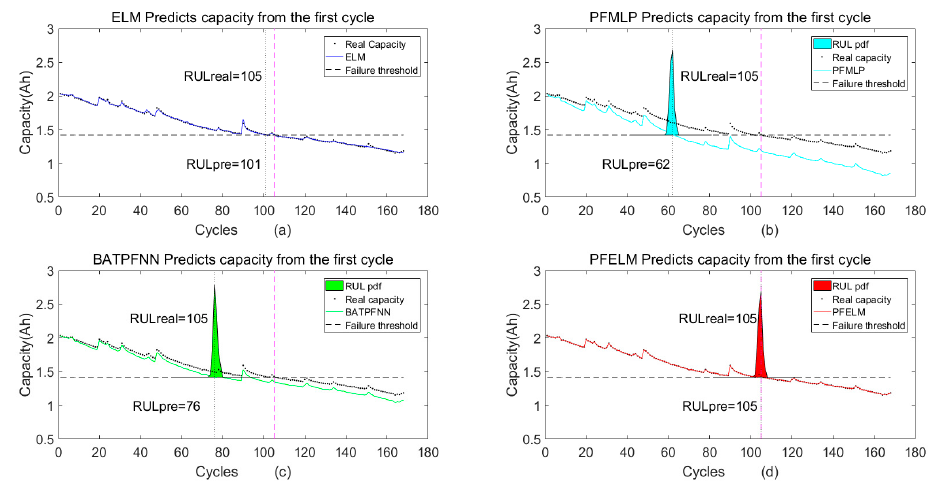
Figure 10. Predicting capacity from the first cycle by different algorithms: ( a ) ELM ; ( b ) PFMLP; ( c ) BATPFNN; ( d ) PFELM.